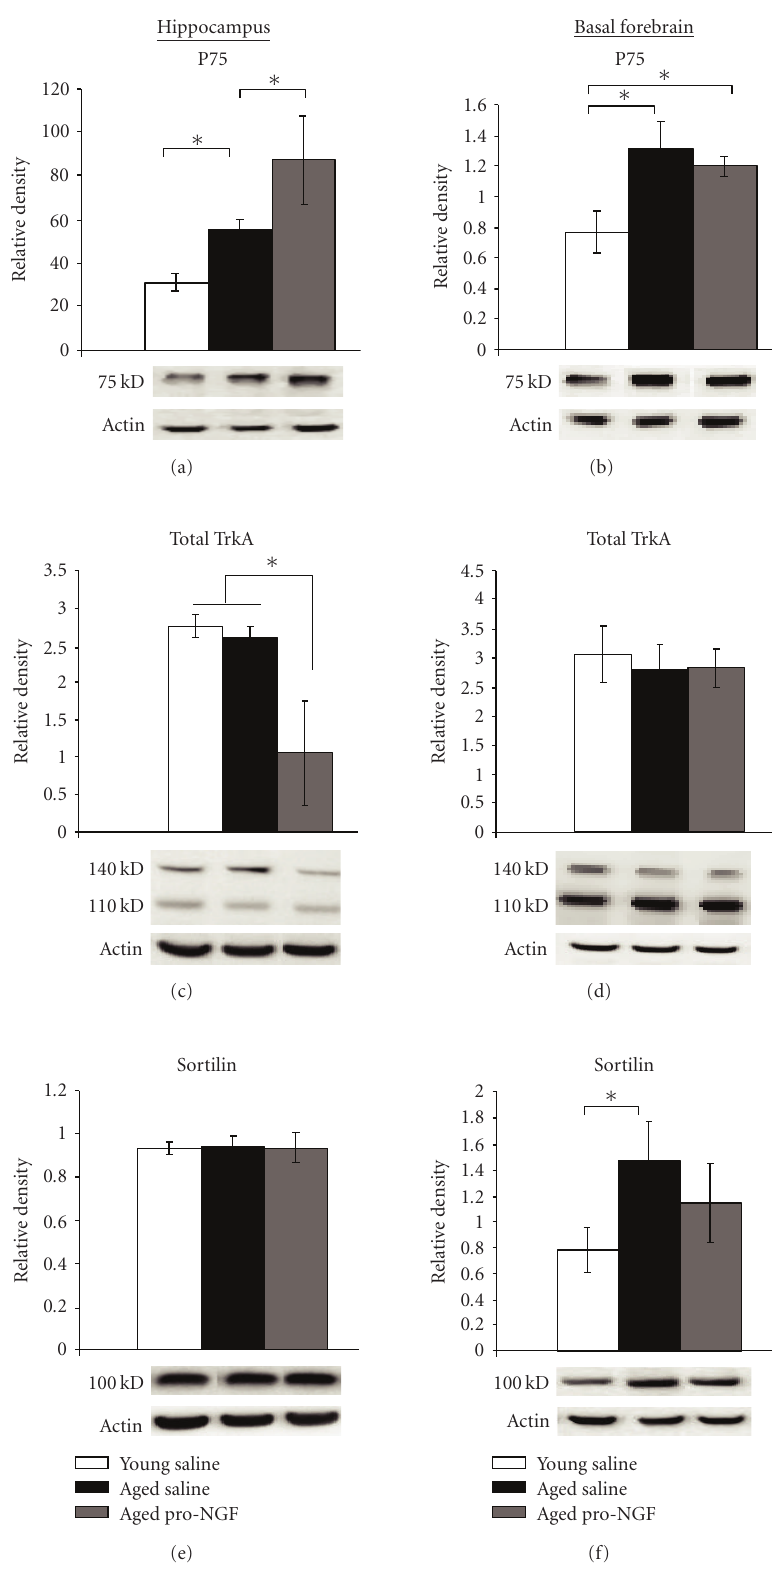
Figure 3: Aging resulted in an increase of p75NTR in the hippocampus (a) and basal forebrain (b), but only in the hippocampus was pro-NGF capable of significantly increasing p75NTR (a). Pro-NGF treatment decreased total hippocampal trkA (c) but did not significantly decrease total basal forebrain TrkA (d). Sortilin levels were not altered in the hippocampus (e) or basal forebrain (f). Changes in protein levels were normalized to β -Actin; ∗ P ≤ .